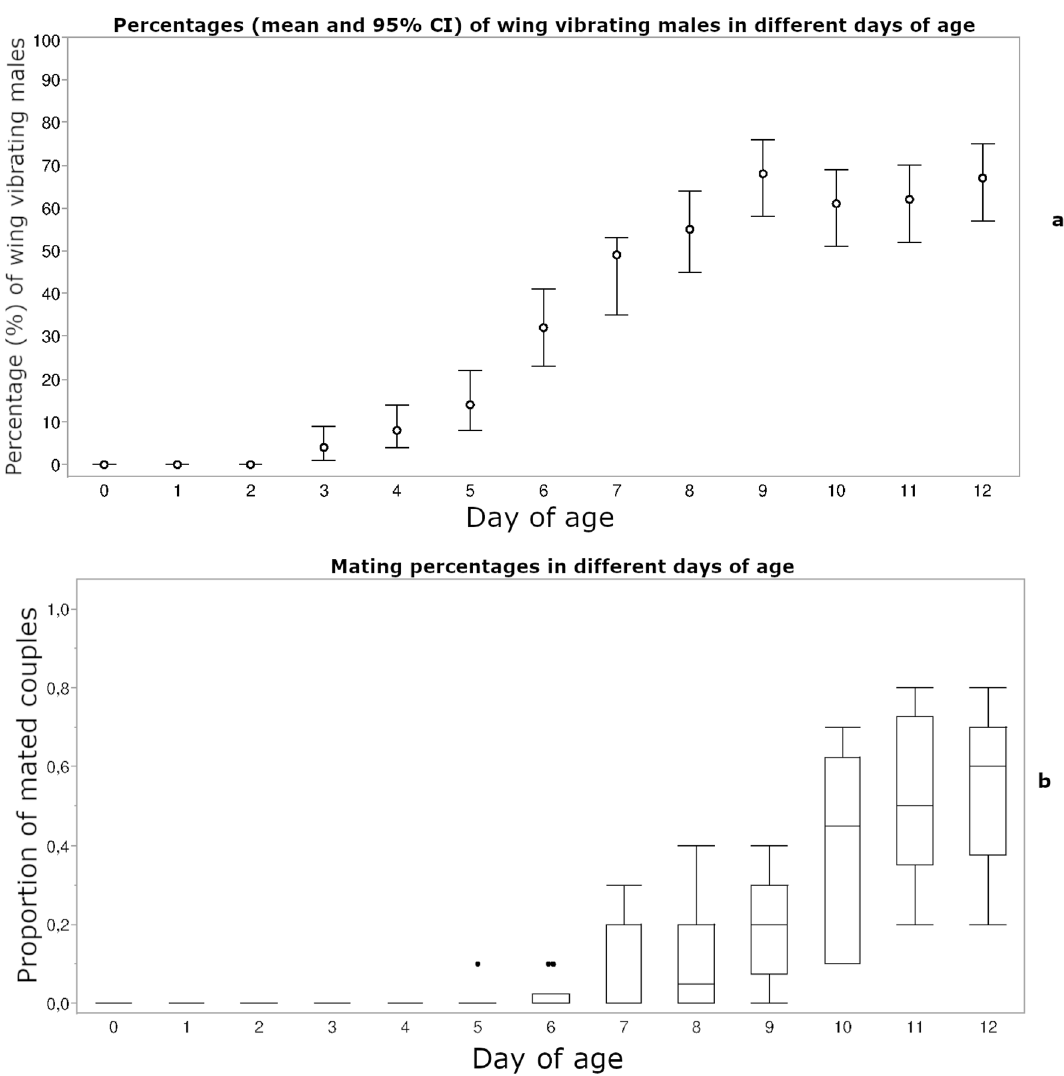
Figure 2. Percentages (mean and 95% CI) of wing vibrating males ( a ) and mating percentages ( b ) in different days of Supplementary Fig. S4). First matings occurred 4 h before the end of the photophase and the maximum was reached 2–2.5 h later. Test 5: Male wing vibration parameters and behaviors in different social situations. In single males, 4% (95% CI: 1–9%) of the individuals were observed engaging in wing vibration during the last 2 h of the photophase and the mean time spent signaling was 113.00 ± 15.55 s. In the presence of a virgin female, 28% (95% CI: 20–37%) of males were observed engaging in wing vibration for a mean time of 94.70 ± 65.79 s. Copu- lations followed quickly in the majority of observations, but when females were not immediately receptive for mating, the males were seen wing-vibrating in several observations and attempted unsuccessful copulations. In the presence of a mated female, 36% (95% CI: 27–45%) of males were observed wing vibrating for a mean time of 100.55 ± 97.60 s and no copulations occurred. In male–male pairs, 66% (95% CI 56–74%) of males engaged in wing vibration for a mean time of 145.73 ± 72.13 s (Fig. 3). Rivalry behaviors like fighting (including boxing with front legs, often followed by dropping to the bottom of the cage) were observed in 70% (95% CI: 60–78%) of the male–male pairs. 48% (95% CI: 38–57%) of the males attempted copulation with the other males. 30% (95% CI: 21–39%) of the males were observed doing the synchronous wing waving behavior, while they were at opposite positions and with eye contact with each other (Table 2). In single males, the majority were stationary during the observation period, engaging in feeding or cleaning activities and only an extremely low proportion of 4% (95% CI: 1–9%) were seen wing vibrating at 1–2 occasions. The mean fundamental frequency (FF) varied depending on the social context of the male i.e., mean (± SD) fundamental frequency was low in single males (324.40 ± 17.10 Hz), increased when males were maintained in